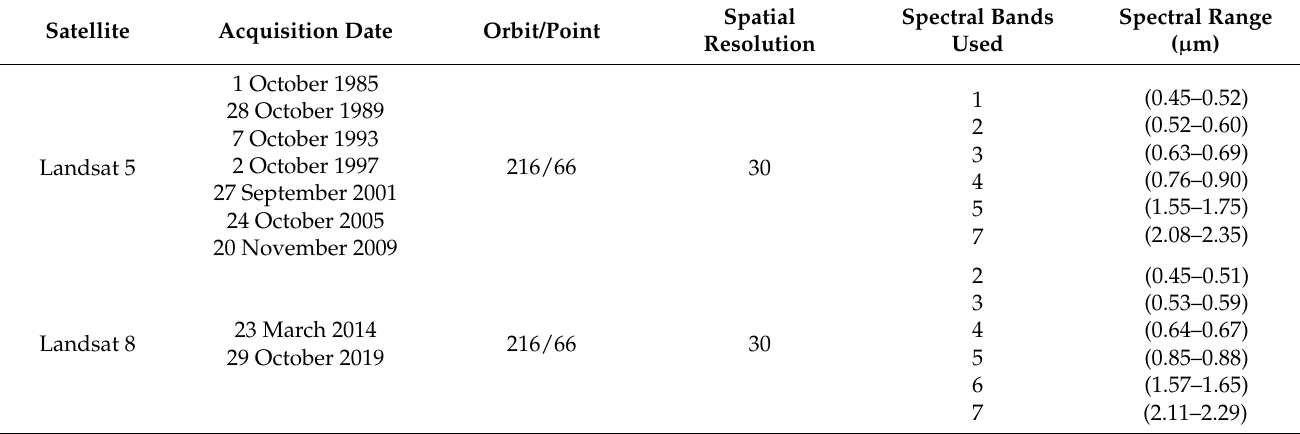
Table 1. Date of acquisition of the evaluated